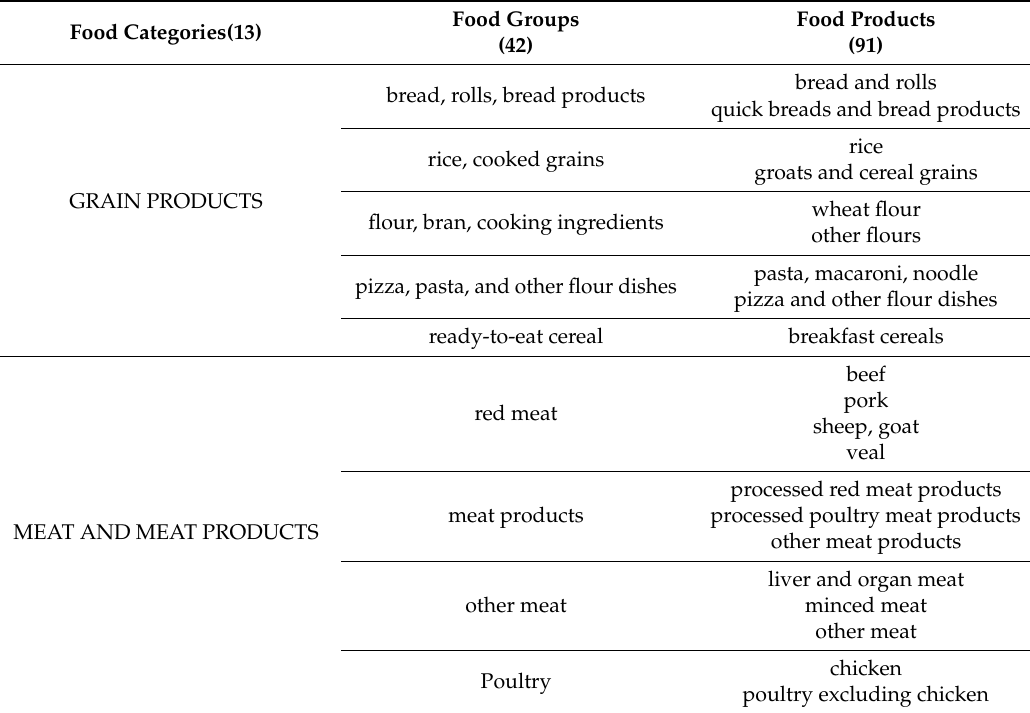
Table 1. Food grouping for the purpose of the nutrient source